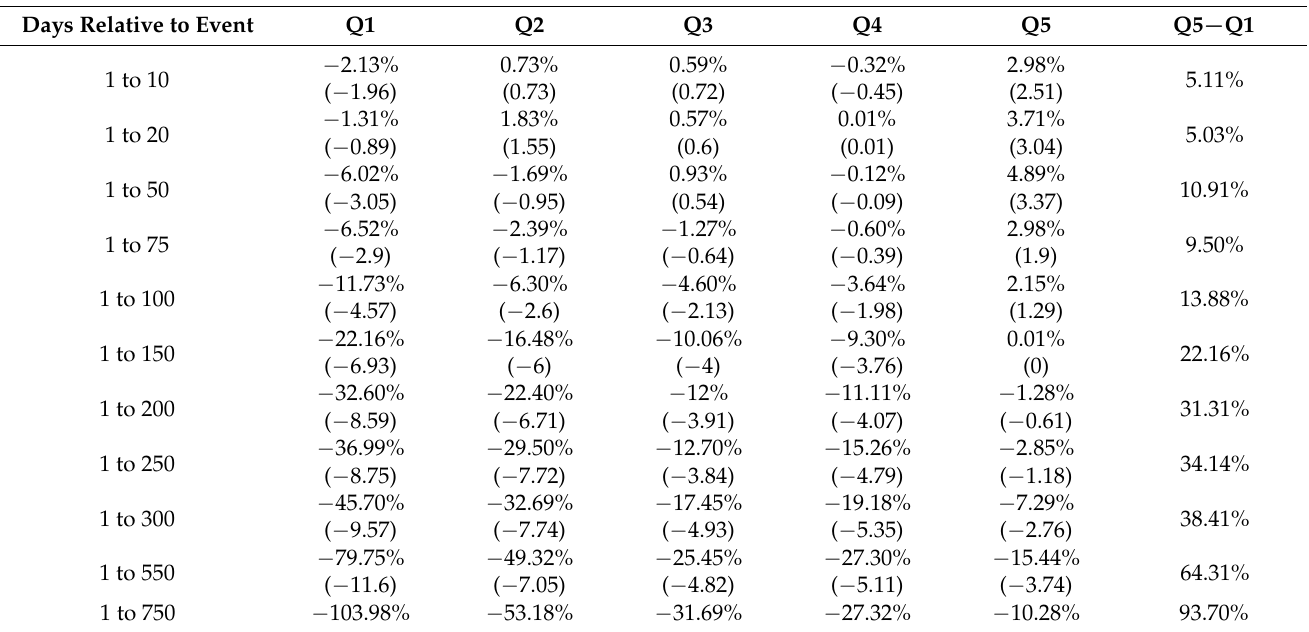
Table 6. Cont. Panel C: CAAR Relative to the Sector Indices